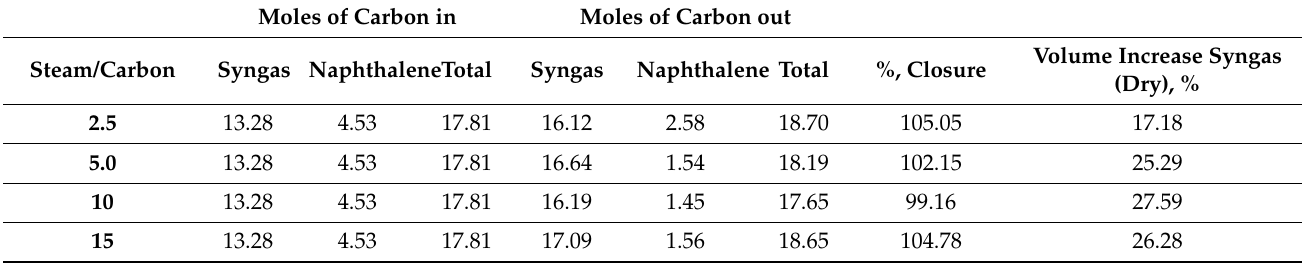
Table 4. Carbon balance: influence of temperature on naphthalene conversion (T—750 ◦ C, GHSV—12,800 h − 1 , catalyst— 7.5% Ni-montmorillonite, naphthalene loading—58 g/Nm 3 ). Moles of Carbon